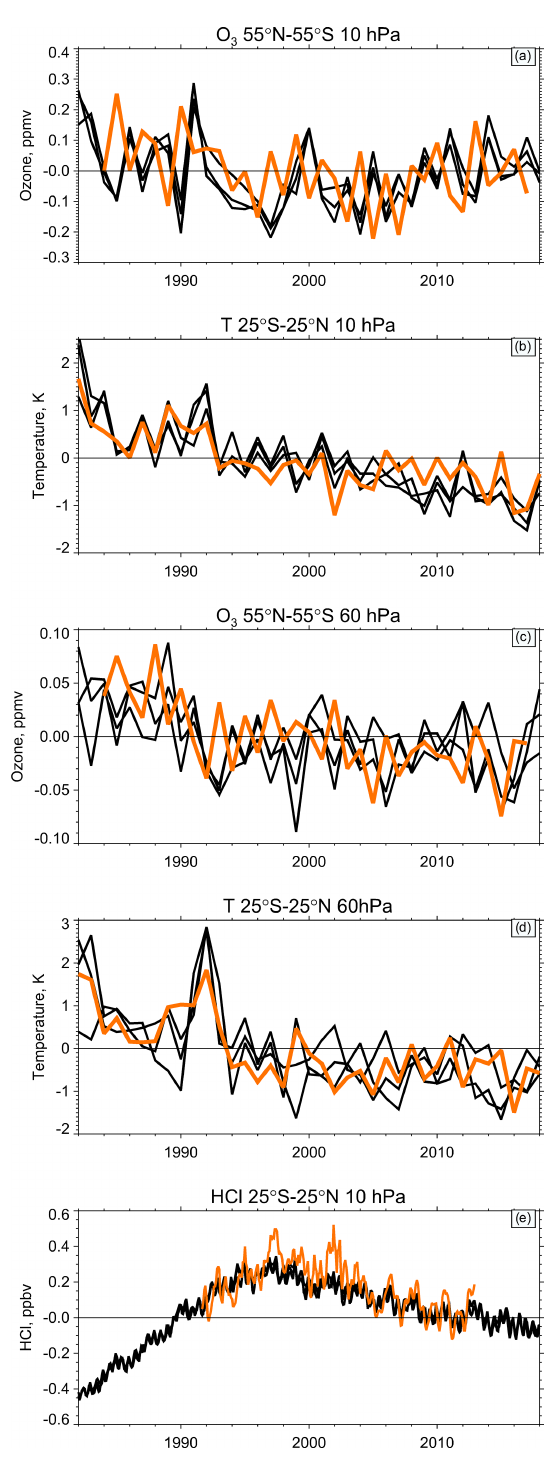
Figure 17. (a, c) Near-global (55 ◦ S–55 ◦ N) annual mean ozone evolution at 60 and 10hPa compared to the BASIC composite. (b, d) Tropical annual mean evolution of temperature at 60 and 10hPa compared to ERA5. (e) Tropical monthly mean (smoothed with the 3-month running mean) evolution of HCl at 10hPa com- pared to the GOZCARDS composite. Black lines: three model en- semble members. Orange lines: